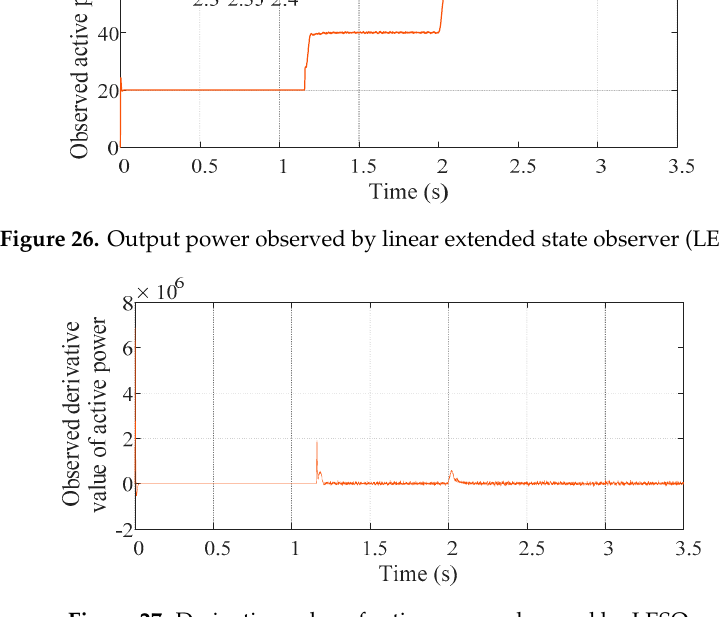
Figure 27. Derivative value of active power observed by LESO.